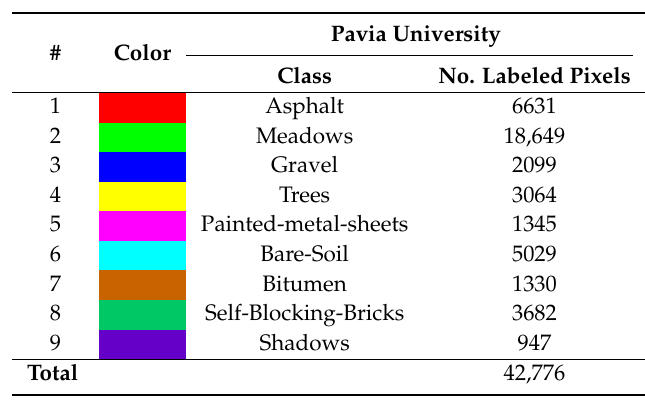
Table 3. Class information and labeled spectrum numbers of Pavia